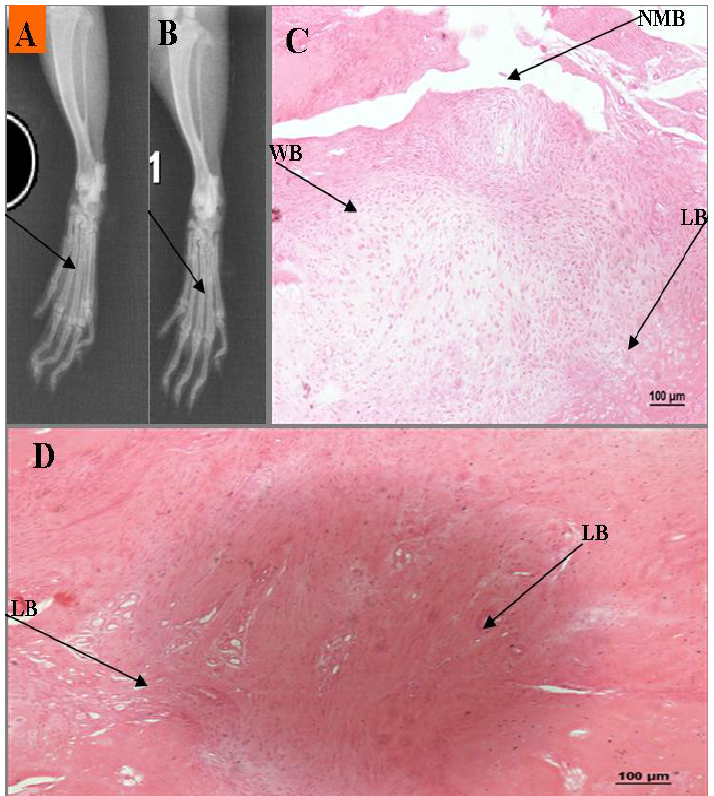
Figure 3. The representative of radiographic and light micrographic features of the fracture healing at week 5 and 7 post operation indicating non delayed union healing. (A and B) anterior posterior (AP) view of 3rd metatarsal healing at week 5 and 7 respectively, arrows indicate the fracture line bridged with mineralized bone. (C), histological features at week 5, the arrows indicates woven bone (WB), lamilar bone (LB) and non-mineralized bone (NMB). (D), histological healing at week 7, the arrows indicate predominant lamilar bone structures. Scale bar =100 µm in all panels, X10 objective. Slides were stained with H and